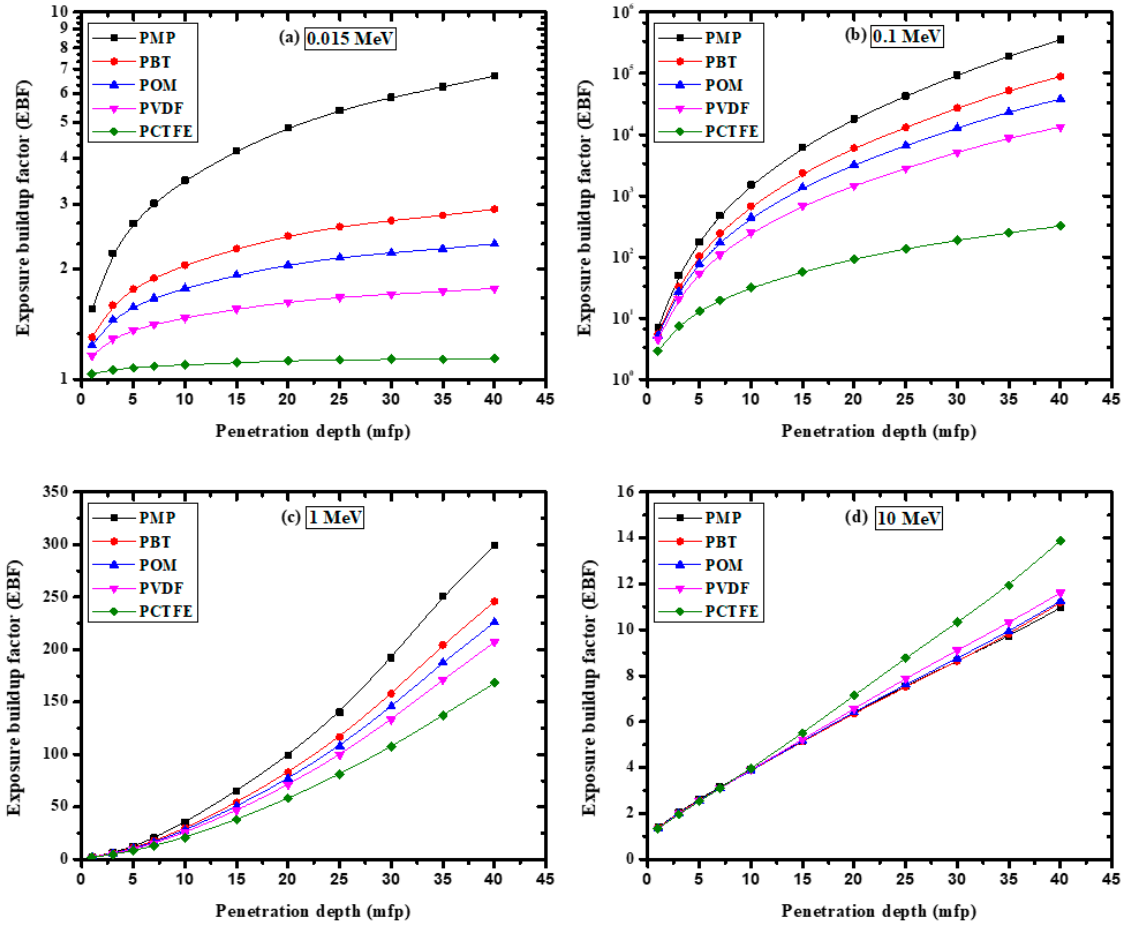
Figure 11. The variation of the exposure buildup factor with penetration depth for the tested polymers at ( a ) 0.015 MeV, ( b ) 0.1 MeV, ( c ) 1 MeV, and ( d ) 10 MeV.